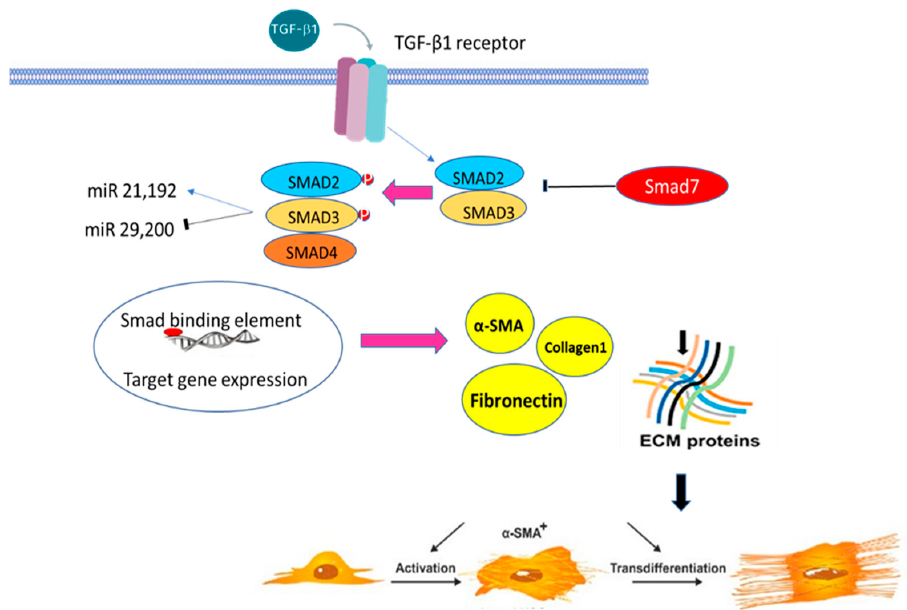
Figure 3. Activation of TGF- β ; transforming growth factor-beta, α -SMA; alpha-smooth muscle